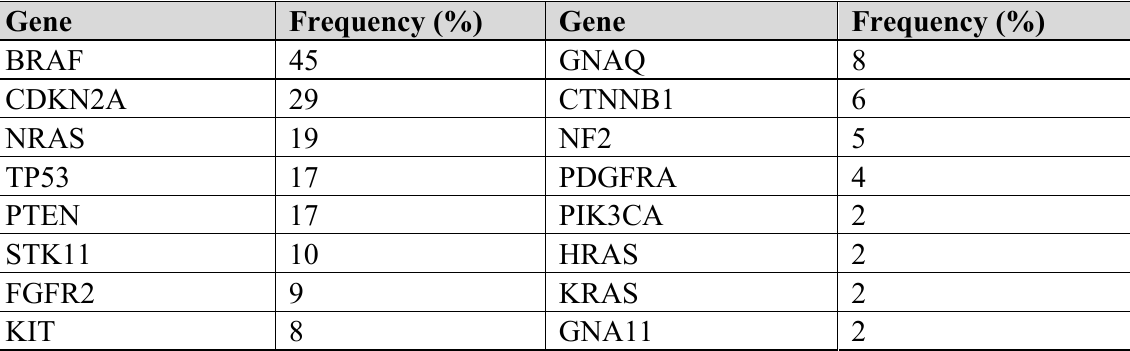
Table 2. Genes most frequently mutated in melanoma. Data from COSMIC database, (accessed on 20 November